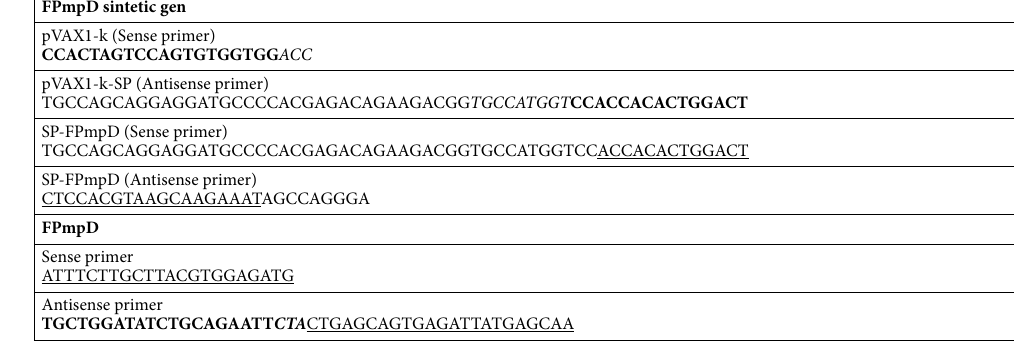
Table 1. Primer sequences used for cloning. Regions in bold hybridize to pVAX1, Underlined regions hybridize to the Ct-PmpD sequence. Italicized regions correspond to the kozak sequence (k). The unmodified regions correspond to the signal peptide (SP). Bold italic regions correspond to the stop